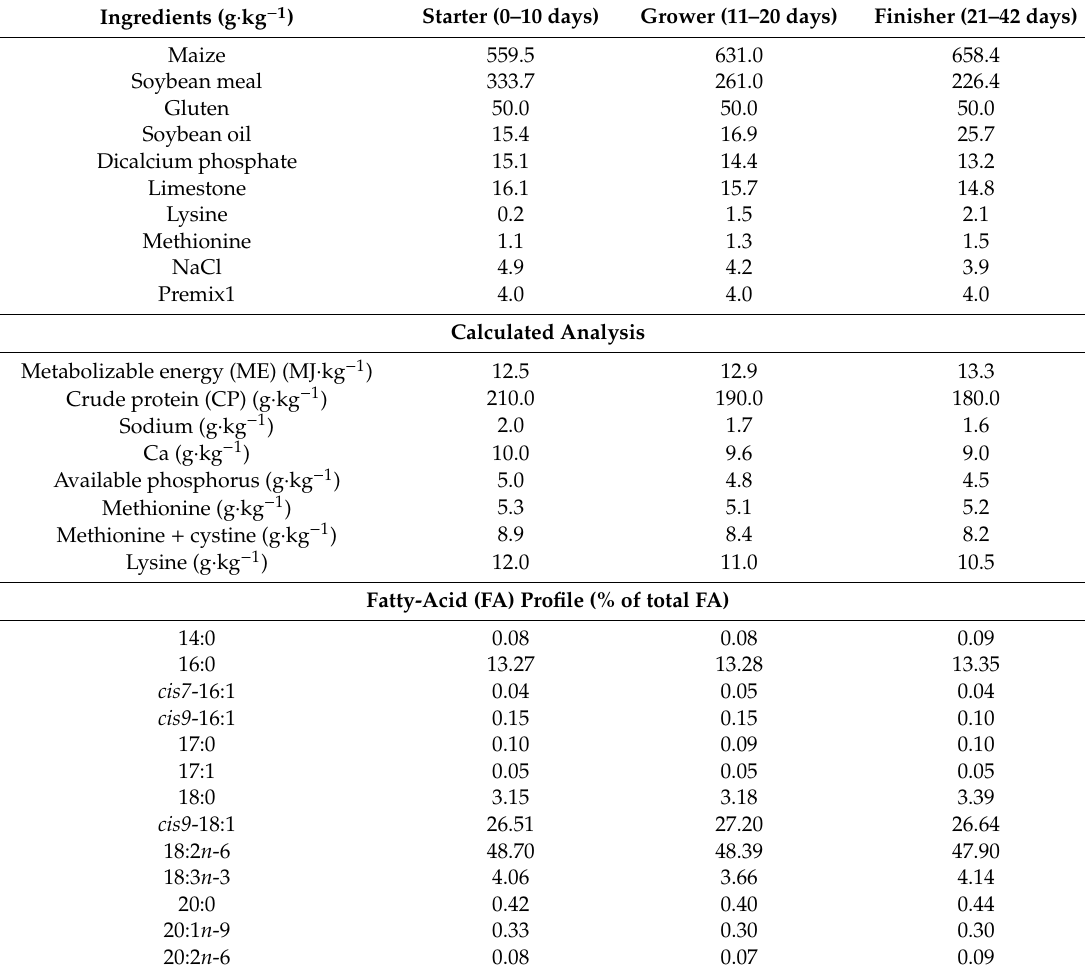
Table 1. Composition (g · kg − 1 ) and calculated analysis of the experimental broiler